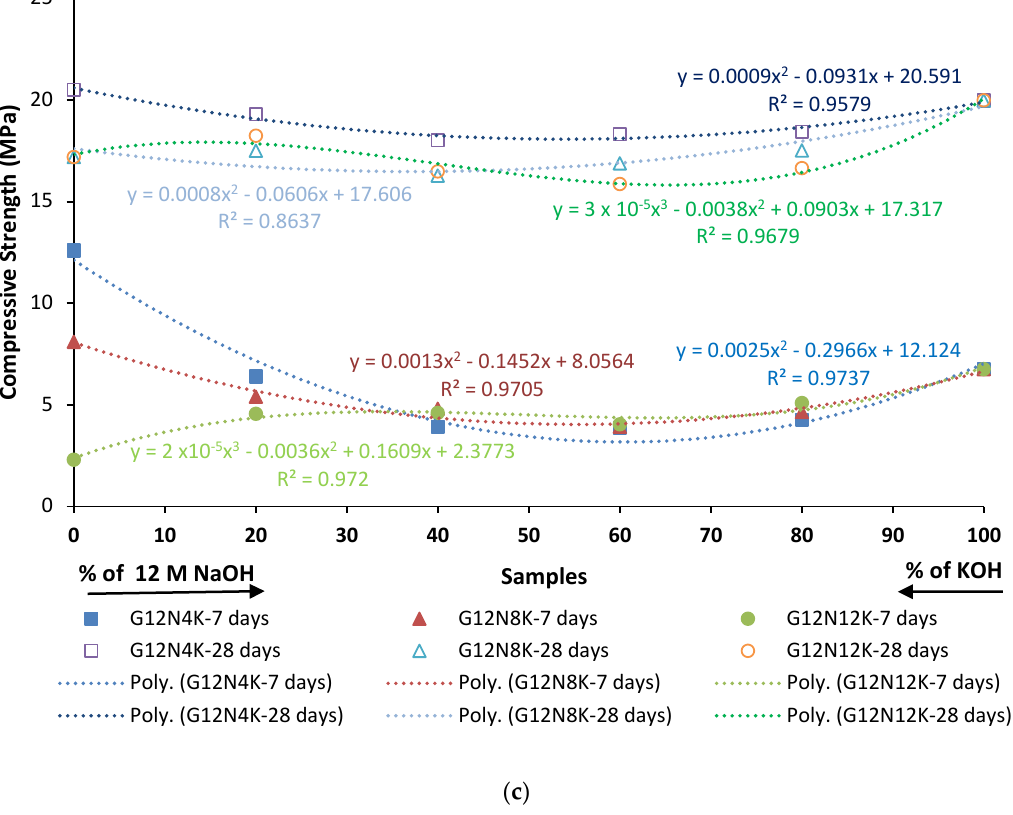
Figure 10. Compressive strength at different percentages of activator solution with respect to activator percentage: ( a ) for 4 M samples, ( b ) for 8 M samples, and ( c ) for 12 M samples.